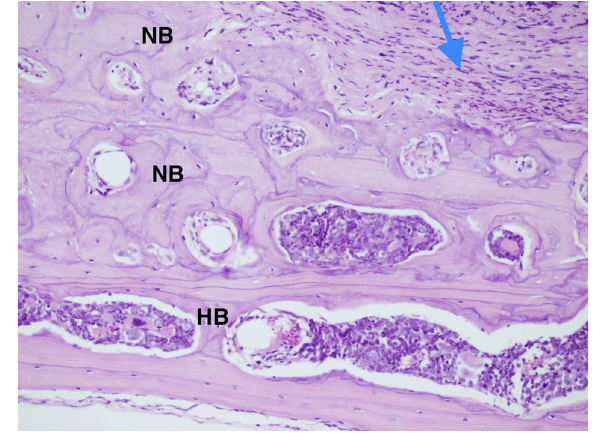
Fig. 7 Photomicrograph showing the thickness of the host cranial bone (HB) next to the grafted tissue (blue arrow). The new bone (NB) regeneration reached more than double the thickness of non-operated bone, scale bar = 100 μ m